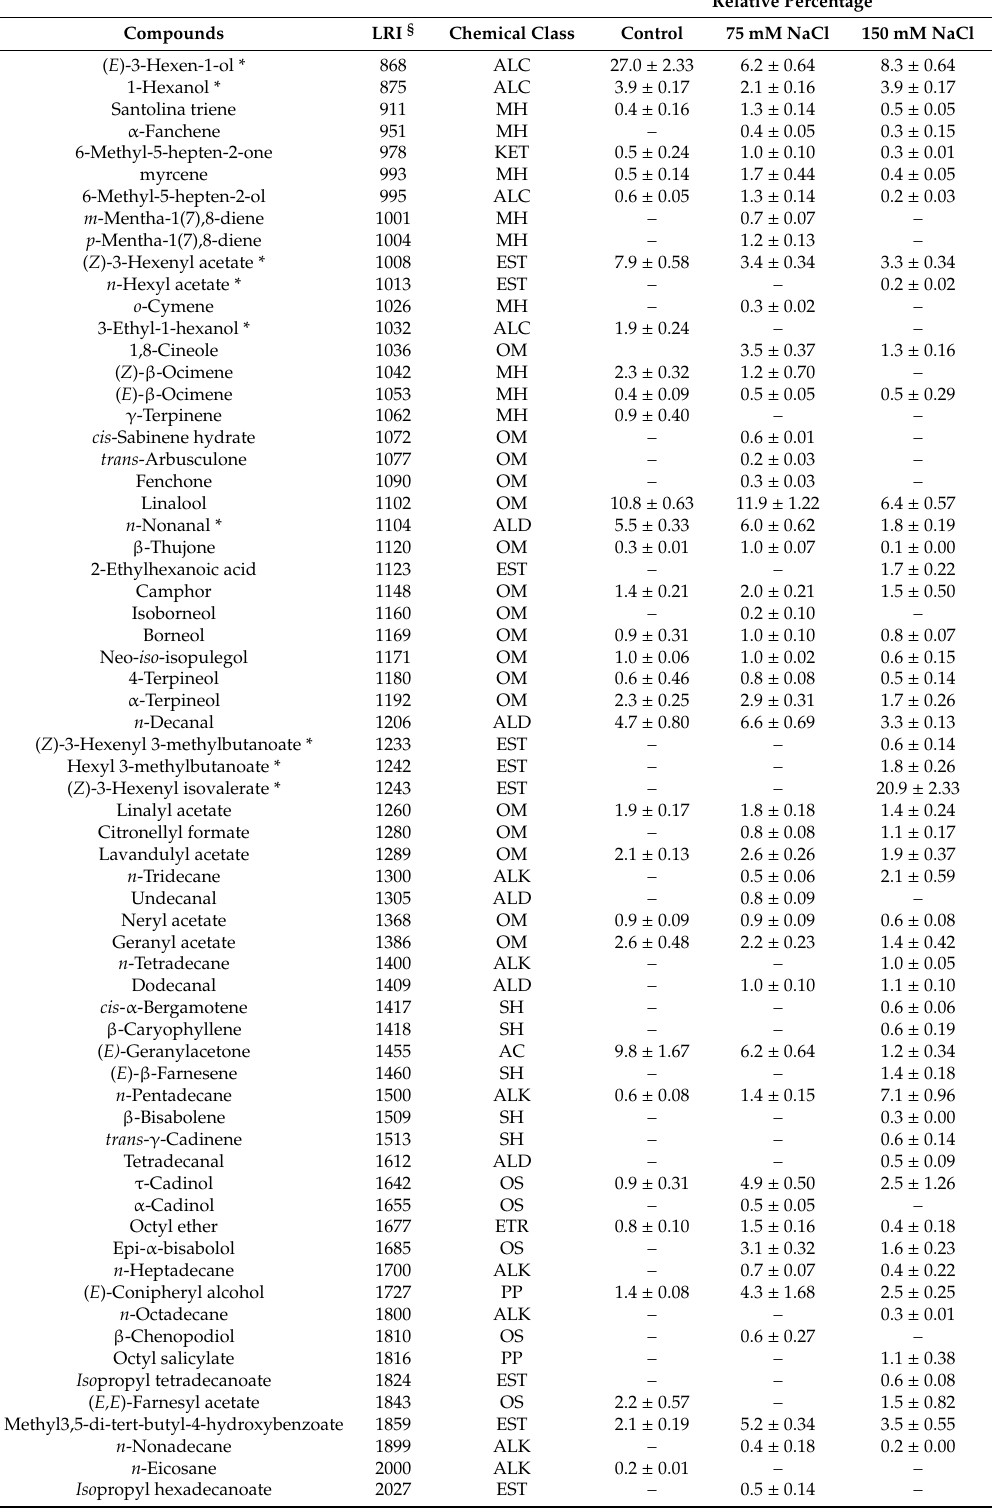
Table4. Chemicalcompositionofthevolatileorganiccompounds(VOCs)fromfreshleavesof Lawsoniainermis plants grown with variable salinity concentrations. HeadSpace–Solid Phase MicroExtraction (HS-SPME) was performed on Gas Chromatography–Mass Spectrometry (GC–MS) with DB-5 capillary column. Data represent mean values of relative percentage ( n = 3, ±